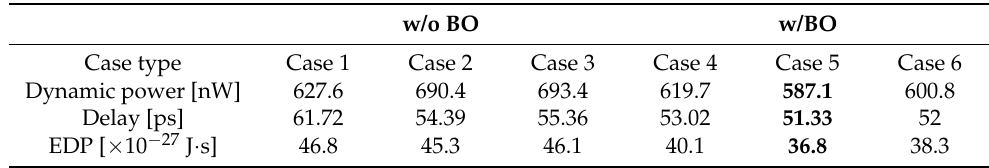
Figure 10. ( a ) Conventional 28T-FA schematic, ( b ) input/output versus time for case 5 when the V DD is 0.7 V.